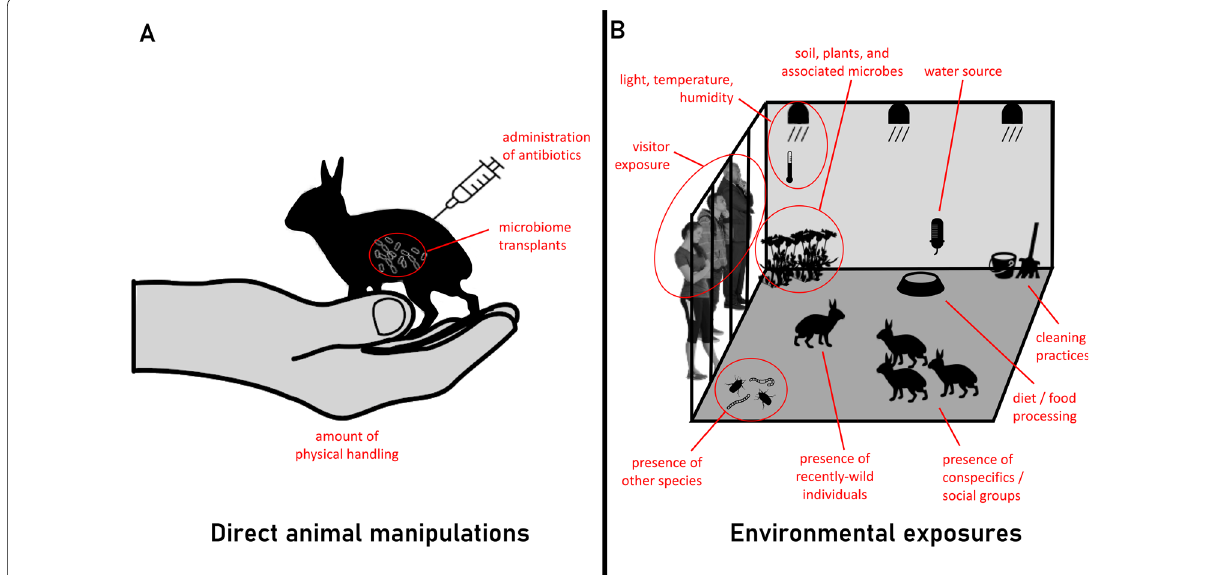
Fig. 1 Possible interventions for manipulating the captive animal microbiome. A Direct animal manipulations include administration of antibiotics, microbiome transplants, and physical handling. B Manipulations targeting environmental exposures include presence of other animals (other species, conspecifics, and recently-wild individuals), diet and food processing, water source, cleaning practices, visitor exposure, climate, and soil, plants, and their associated microbes. Icons have been adapted under a Creative Commons license (https:// creat iveco mmons. org/ licen ses/ by/3. 0/) at phylopic.org and thenounproject.com. The hand image was sourced from clipart-library.com under a Personal Use